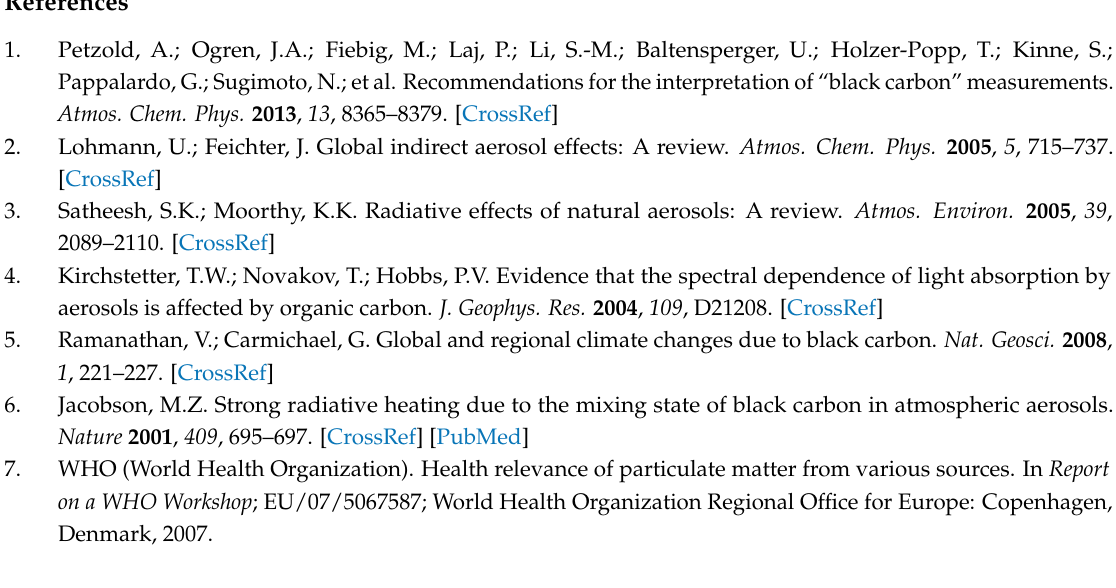
Figure S1: Regression of the aerosol absorption coefficients ( b abs ) at 880 nm versus elemental carbon (EC) concentrations. The data represent 3-h averages and were collected during 03/2013–02/2014, Figure S2: Mean 24-h values of the mass absorption cross-section (MAC), based on the ratio of the absorption coefficients ( b abs ) at 880 nm to EC concentrations, measured during